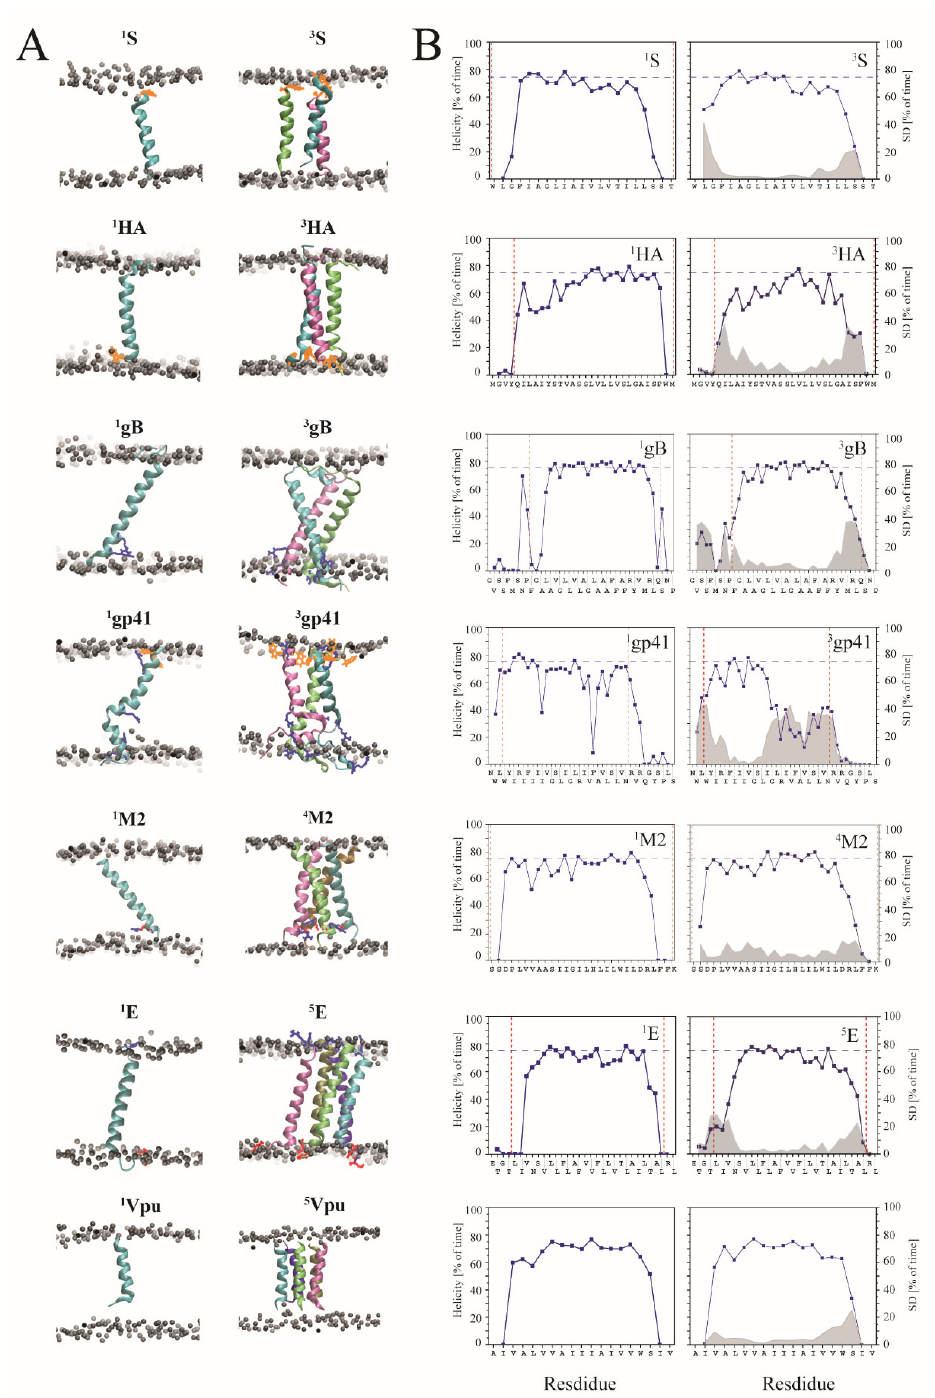
Figure 2. ( A ) Structural models of the peptides in the monomeric and oligomeric state at the end of the 500 ns MD simulations of S protein ( 1 S, 3 S), HA ( 1 HA, 3 HA), gB ( 1 gB, 3 gB), gp41 ( 1 gp41, 3 gp41), M2 ( 1 M2, 4 M2), E peptide ( 1 E, 5 E), and Vpu peptide ( 1 Vpu, 5 Vpu). The structures were taken from experimentally available data. The boundaries of the lipid membrane are marked by grey spheres representing the phosphorous atoms of the lipid head groups. The remaining lipid atoms as well as the water molecules are omitted for clarity. ( B ) The corresponding percentage of time of each residue being in a helical conformation is shown for both monomer (left column) and oligomer with standard deviation in grey when averaging the values for each individual TMD (right column). Red dash lines indicate the boundaries of the lipid membrane.